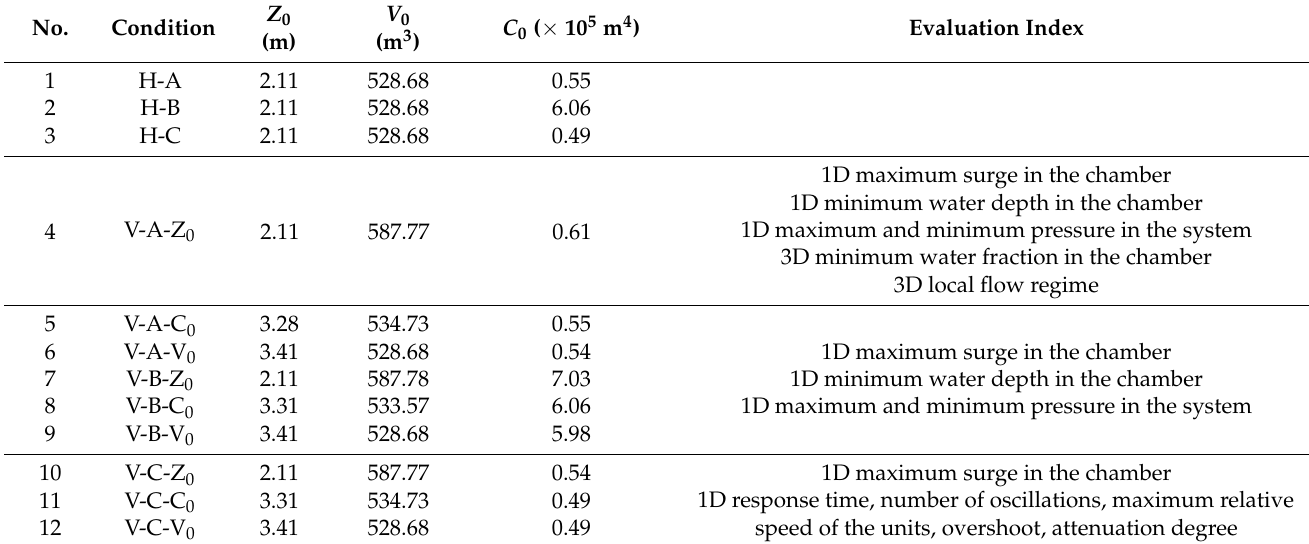
Table 5. Scenarios for comparing vertical and horizontal ACSCs.